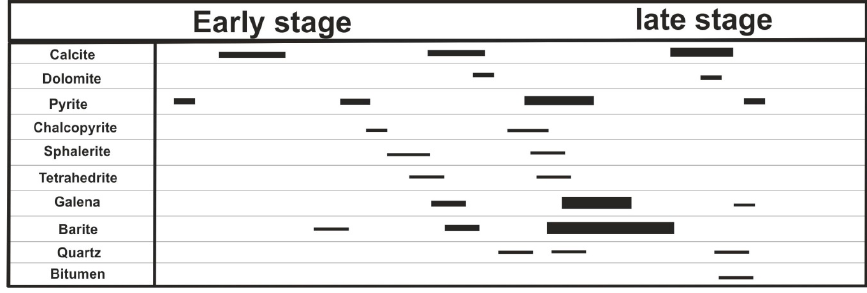
Figure 4. Summary of mineralization paragenesis in the Ravanj deposit (modified after [16]). Table 1. Summary of microthermometric data of the Ravanj deposit